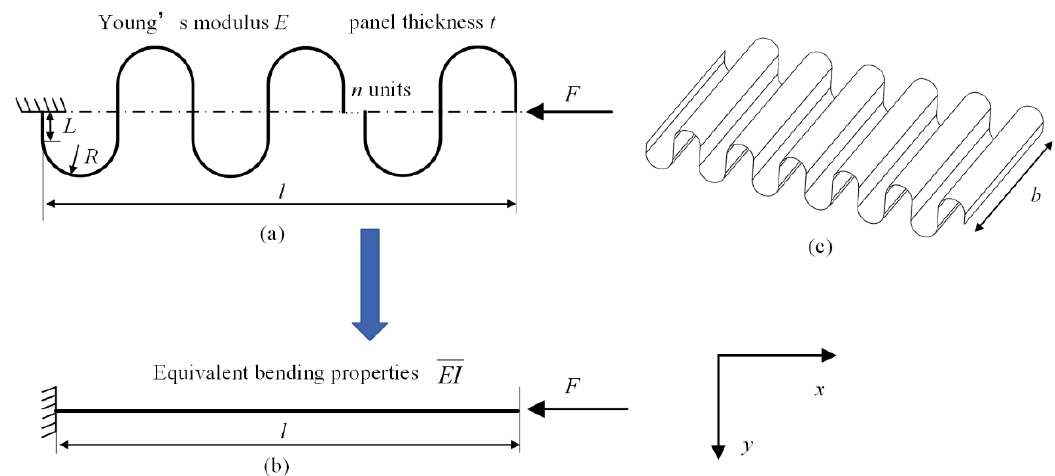
Figure 1. Corrugated panel: ( a ) two-dimensional model, ( b ) equivalent model, ( c ) three-dimensional model.